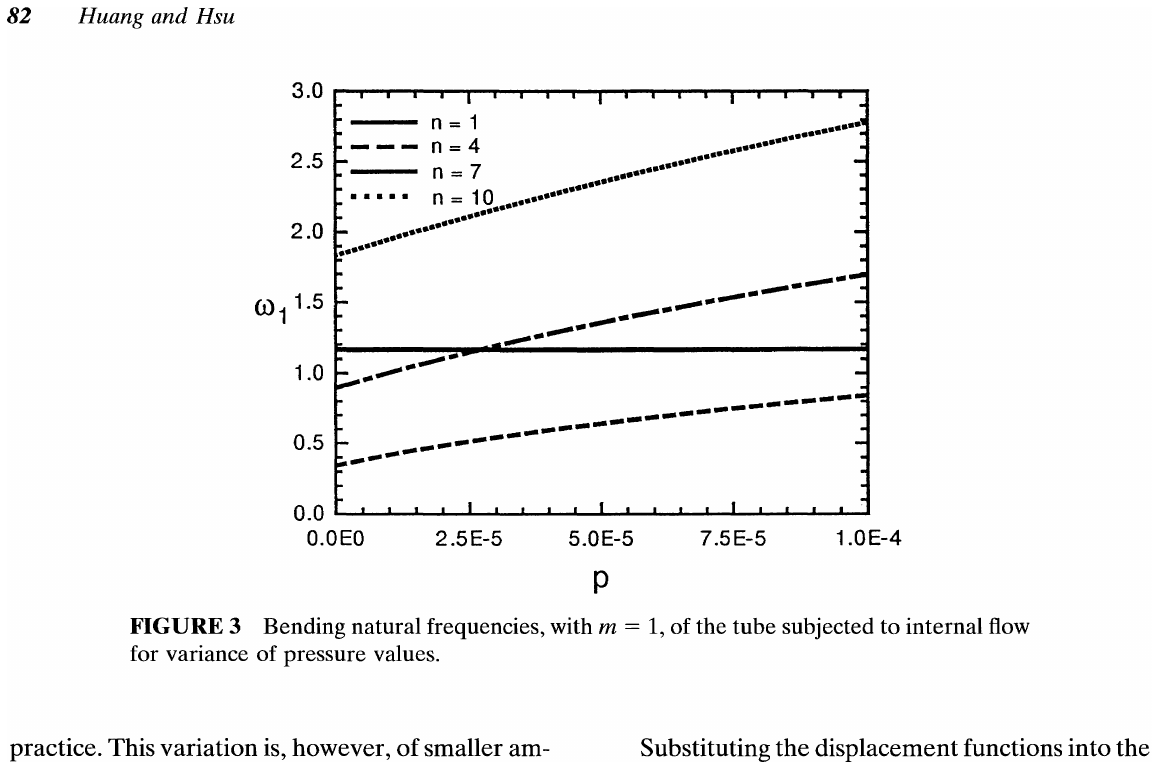
FIGURE 3 Bending natural frequencies, with m = 1, of the tube subjected to internal flow for variance of pressure